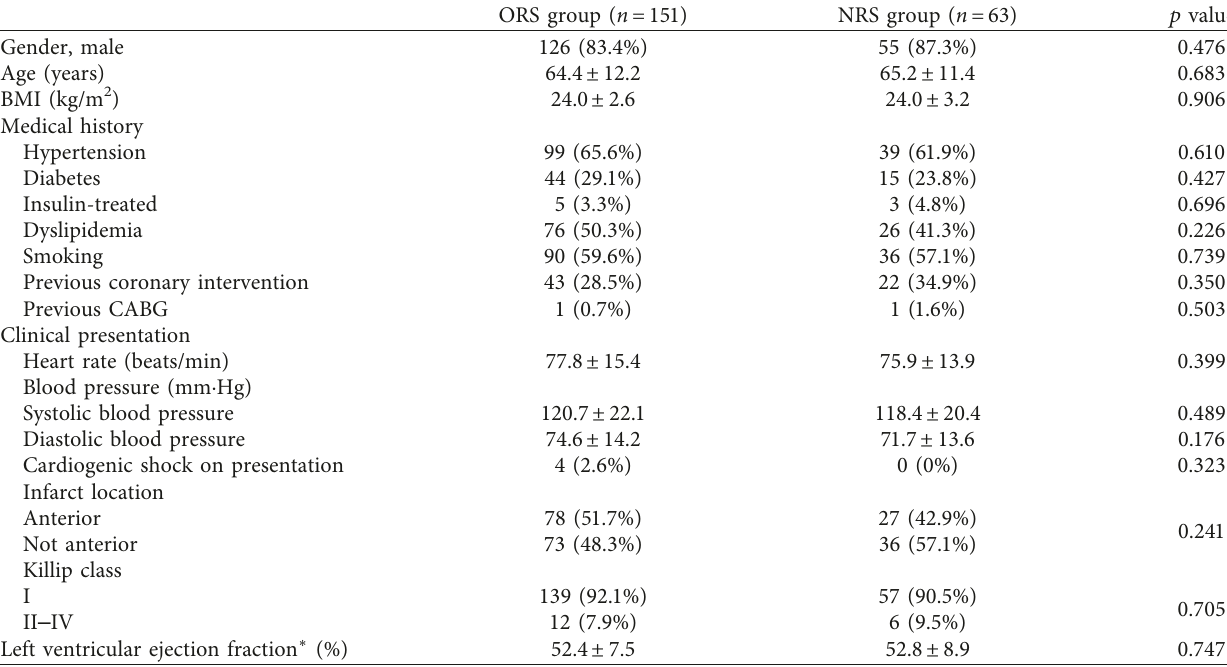
Table 1: Baseline clinical characteristics.